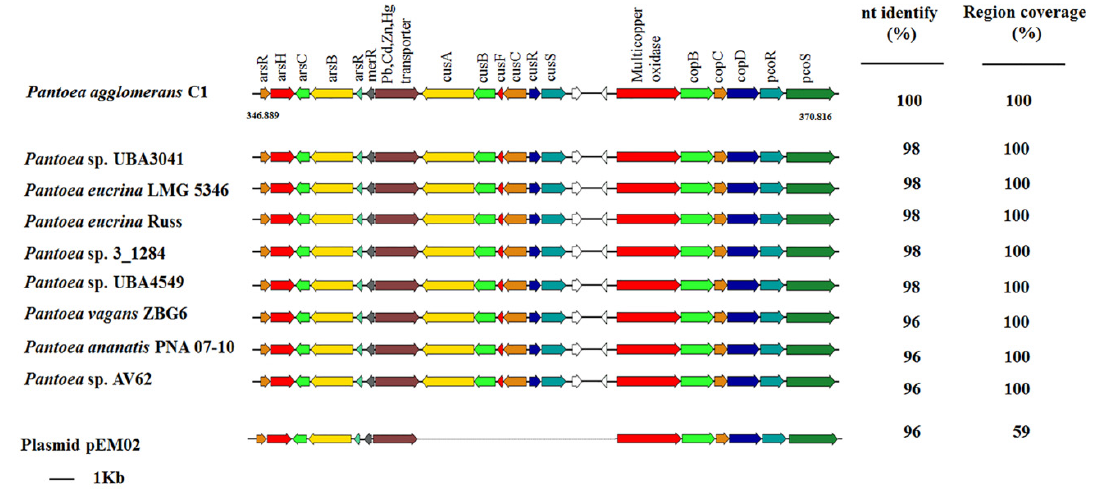
Figure 3. Organization of the heavy metal gene (MRG) cluster of P. agglomerans C1 and comparison with other Pantoea genomes that have the same 19-gene cluster and with pEM02 plasmid from Erwinia sp. EM595 (GenBank reference: LN907829.1). Genes with unknown function are indicated in white. Genome accession numbers are reported in Supplementary Table S1.